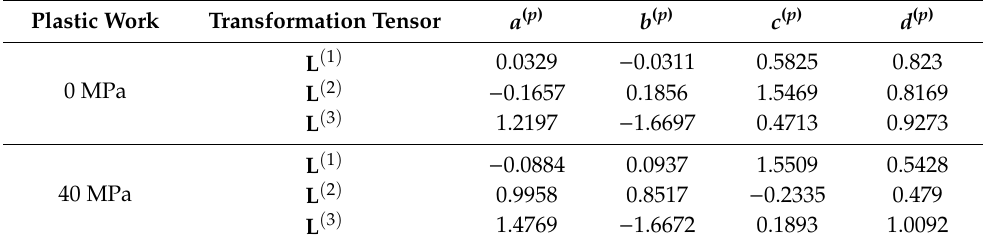
Table 12. Calibrated anisotropy coe ffi cients for the CPB06ex3 function of the niobium sheet under the associated flow rule ( m =